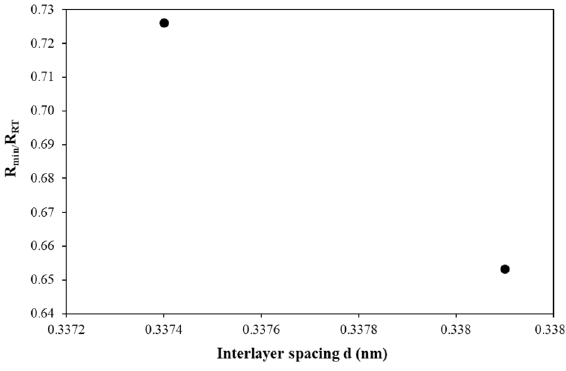
Fig. 12 Correlation between ratio R (d 002